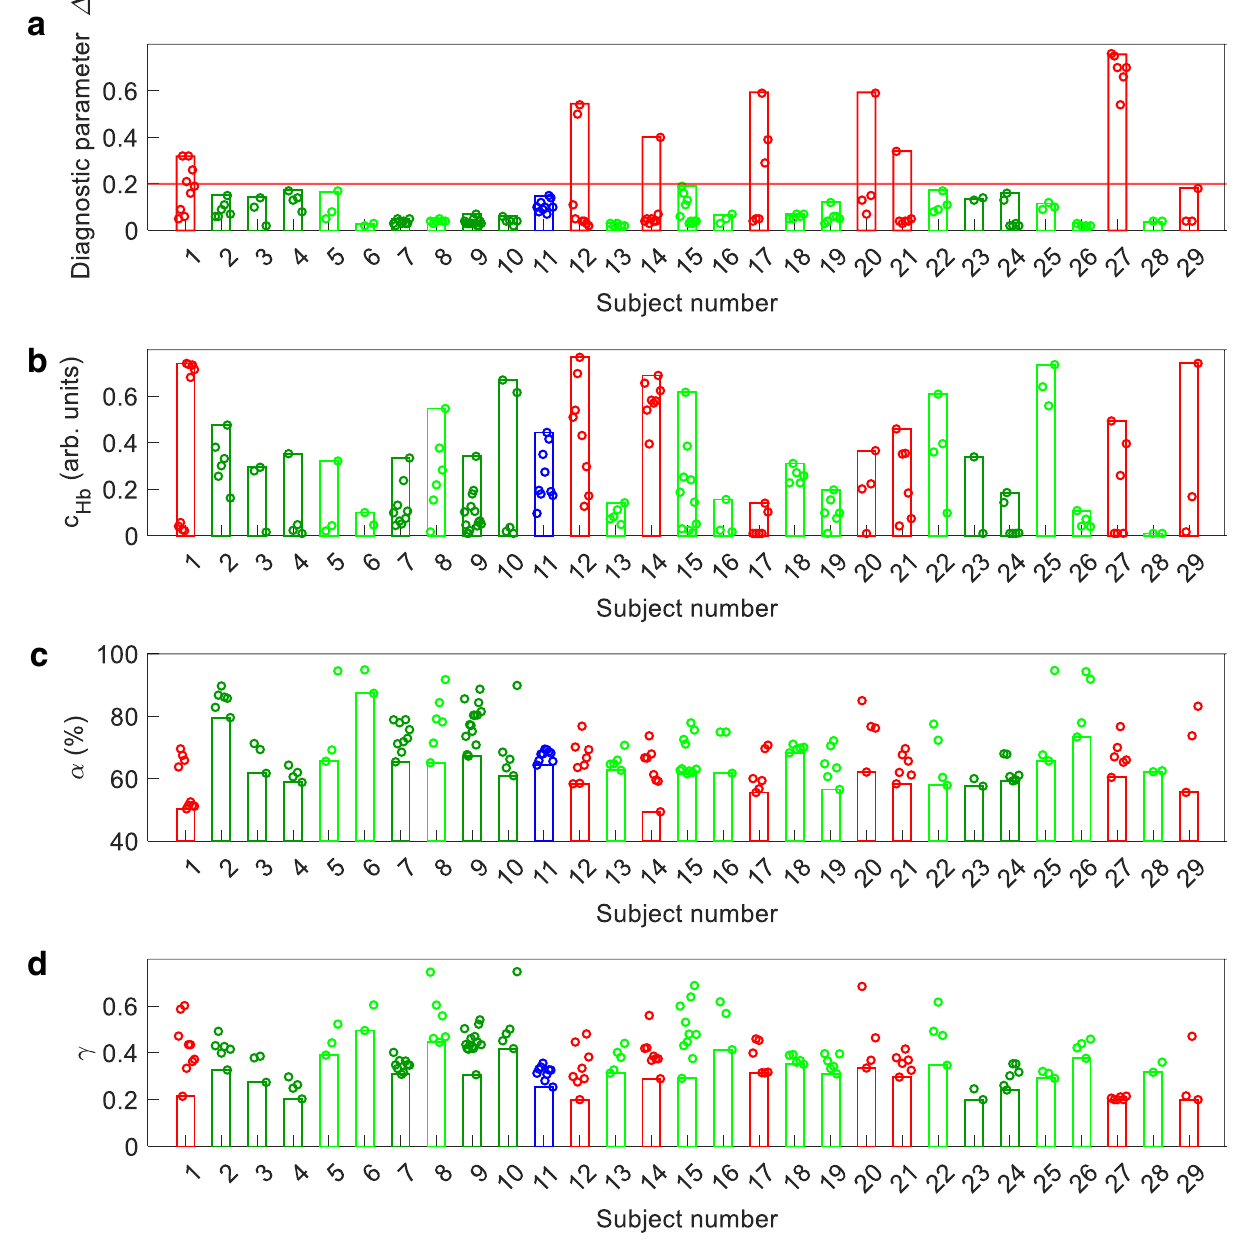
Fig. 6 | Tissue parameters reconstructed from in vivo spectroscopic measure- ments in the bile duct. The bar color represents clinical diagnosis. The red bars represent high-grade dysplasia or cancer, blue – low-grade dysplasia, green — benign with in fl ammation and bright green — benign. Bar heights represent tissue parameters reconstructed from in vivo spectroscopic measurements with the